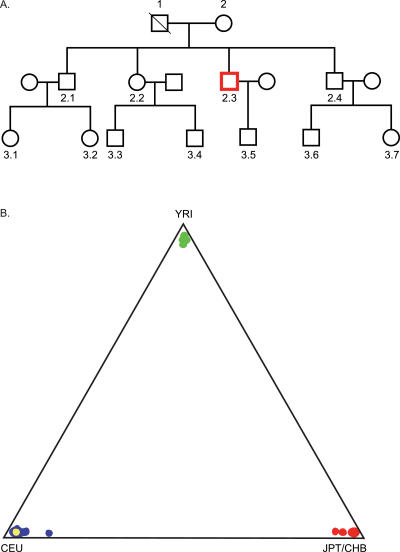
DNA Donor Pedigree and Relatedness to Ethnogeographic Populations(A) Three-generation pedigree showing the relation of ancestors to study DNA sample. The donor is identified in red. (B) Cluster analysis based on 750 SNP genotype information to infer the ancestry of the HuRef donor. The figure shows the proportion of membership of the HuRef donor (yellow) to three pre-defined HapMap populations (CEU = Northern and Western Europe, YRI = Yoruban, Ibadan, Nigeria, and JPT+CHB = Japanase, Tokyo, and Han Chinese, Beijing). The results indicate that the HuRef donor clusters with 99.5% similarity to the samples of northern and western European ancestry.